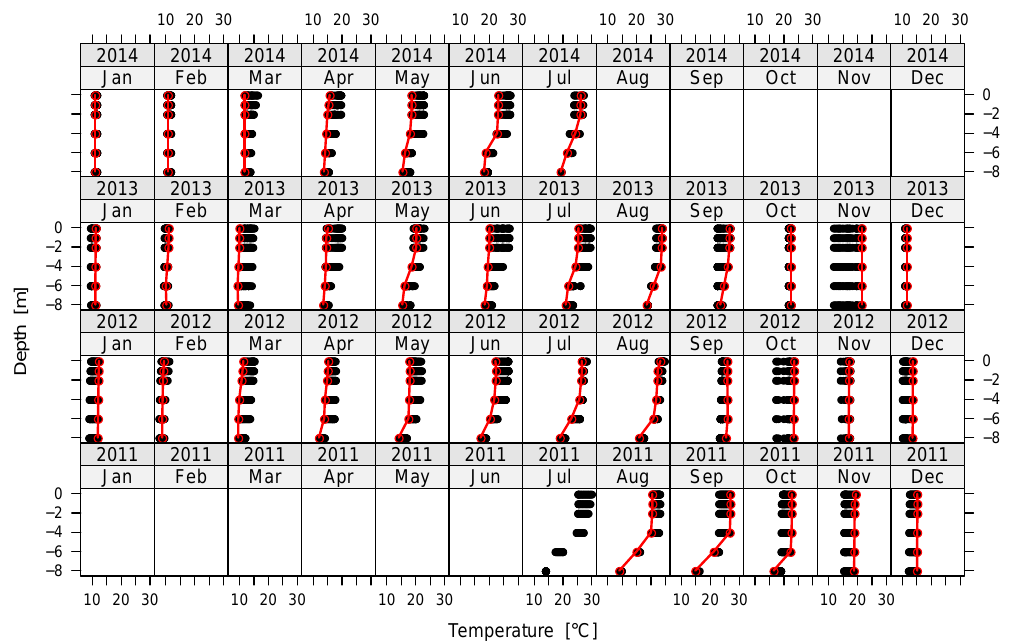
Figure 5. Lake temperature profiles. Black circles are daily average temperatures. Red circles represent the temperature profile on the first of the